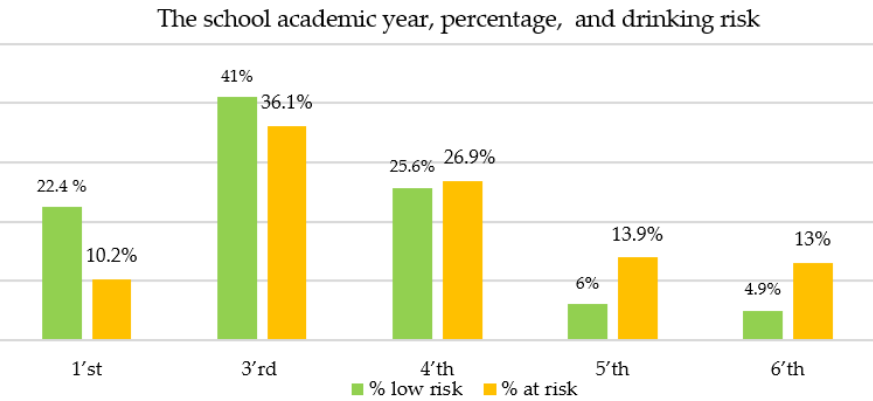
Figure 2. At-risk drinker percentages by school academic year (no data available for the second academic year).